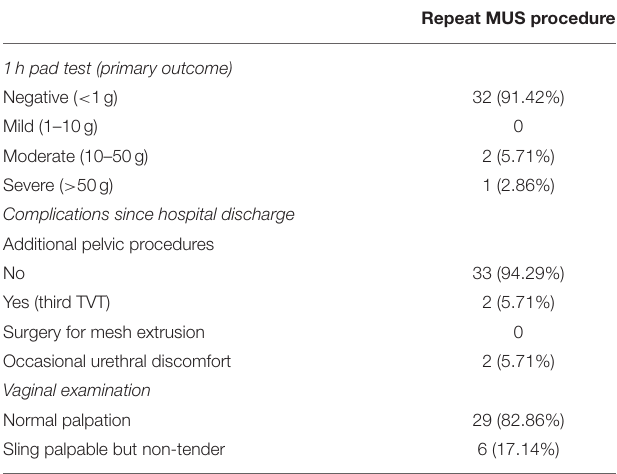
TABLE 2 | Six month